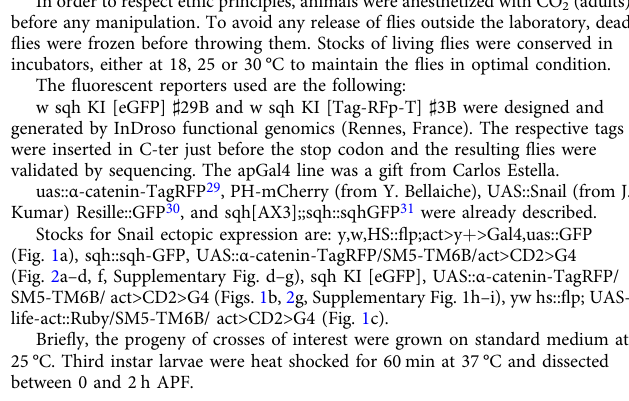
(Fig. 1a), sqh::sqh-GFP, UAS:: α -catenin-TagRFP/SM5-TM6B/act>CD2>G4 (Fig. 2a – d, f, Supplementary Fig. d – g), sqh KI [eGFP], UAS:: α -catenin-TagRFP/